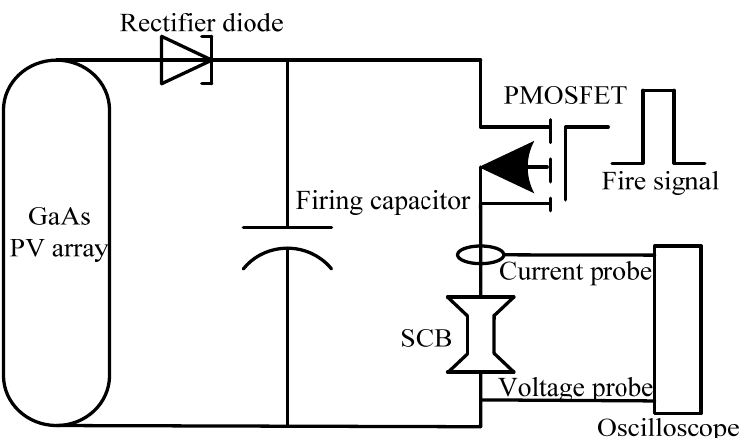
Figure 15. Schematic diagram of integrated energy device initiation performance experimental setup.